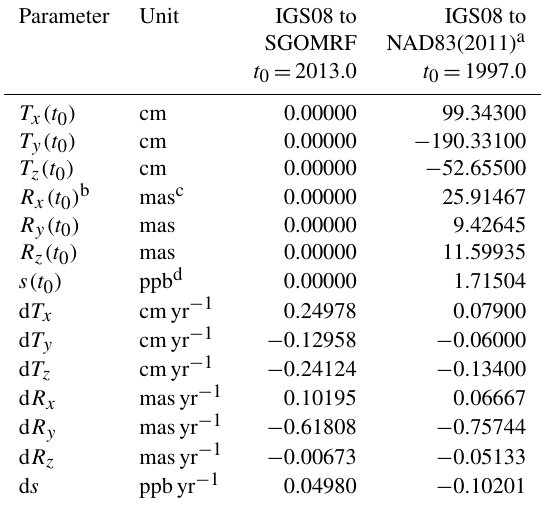
Table 1. Fourteen parameters for reference frame transformations from IGS08 to SGOMRF and from IGS08 to NAD83(2011).